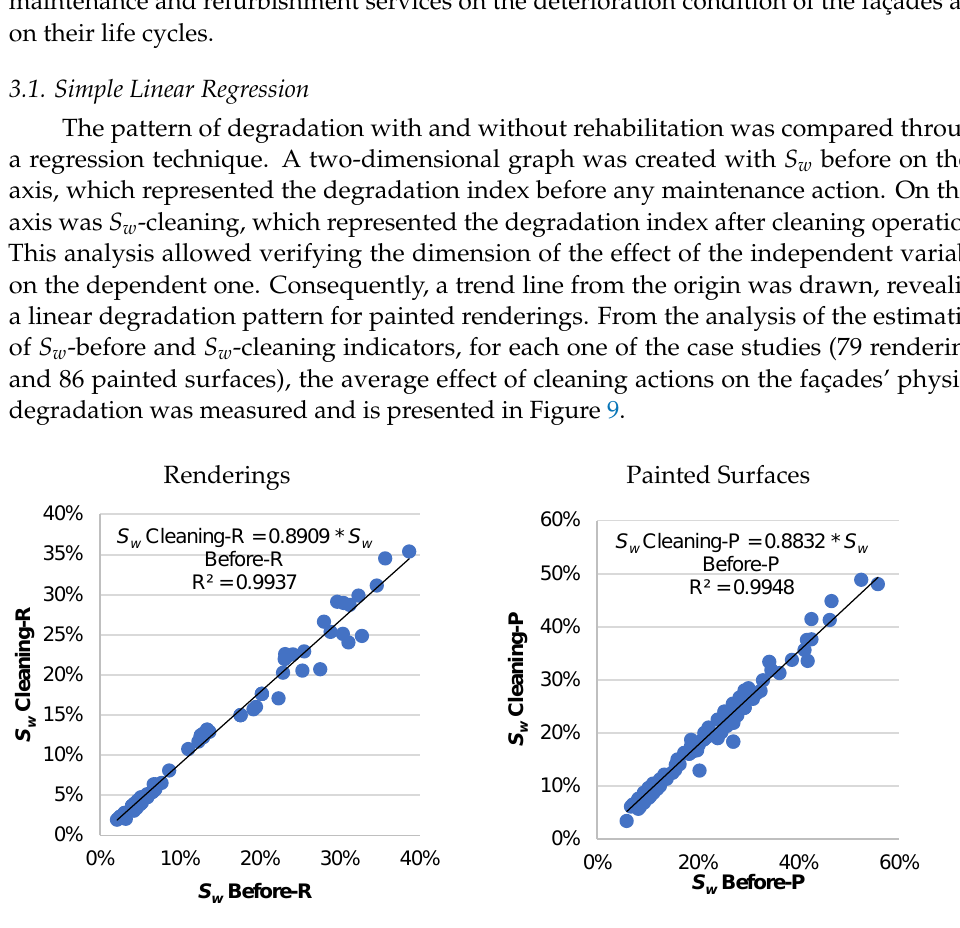
Table 2. Descriptive analysis of the impact of cleaning actions on the severity of degradation in- dex.